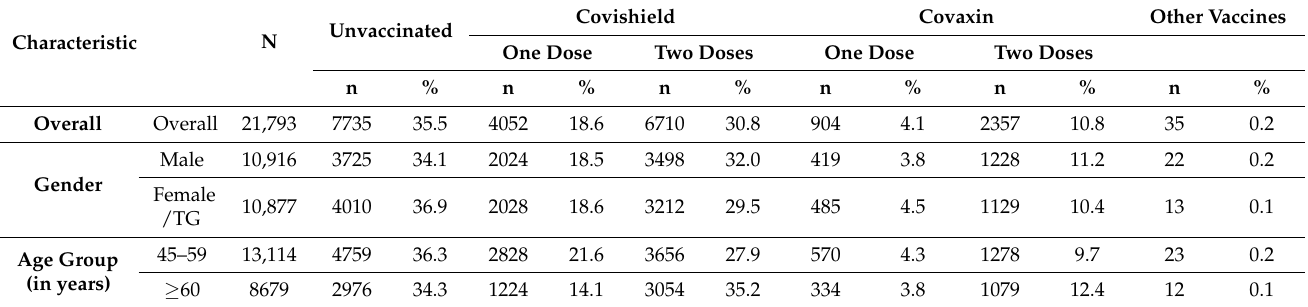
Table 2. Vaccination profile of the individuals ≥ 45 years in the COVID-19 vaccine effectiveness cohort study, Chennai, 2021 (N = 21,793) *.